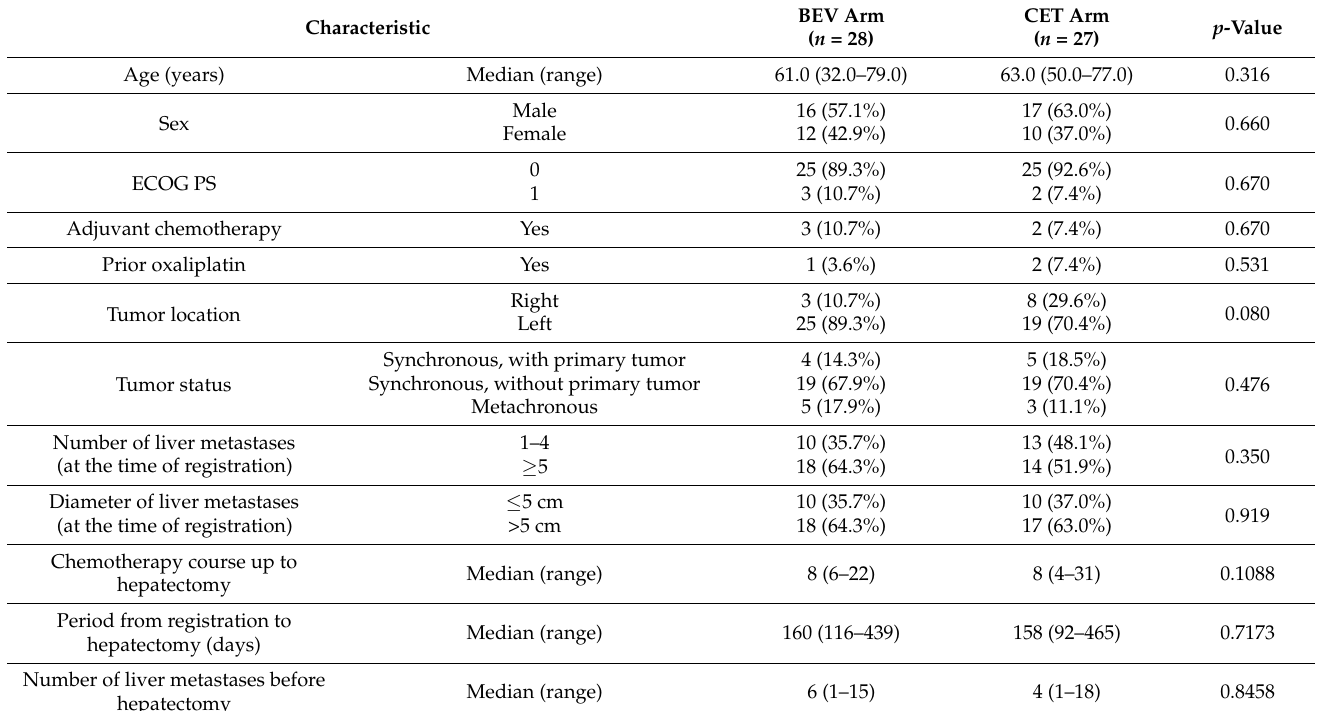
Figure 2. CONSORT flow diagram. BEV, bevacizumab; CET, cetuximab; PD, progressive disease. Table 1. Patient